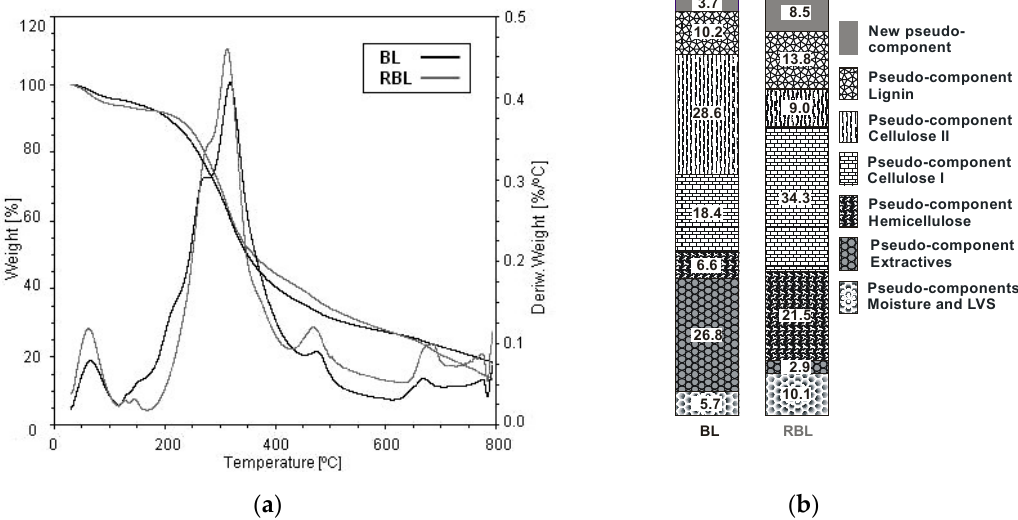
Figure 6. TGA and DTG curves ( a ) along with the results of deconvolution of the DTG curve ( b ) of BL and RBL samples.